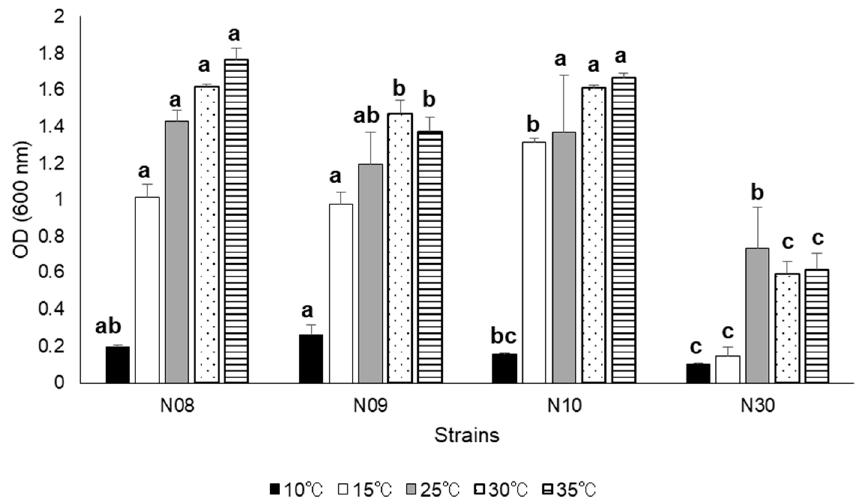
Figure 5. Effect of culture temperatures on growth of GABA producing-four strains. Values indicate the average ± standard deviation ( n = 3). Different letters denoted in column show significant difference ( p < 0.05).